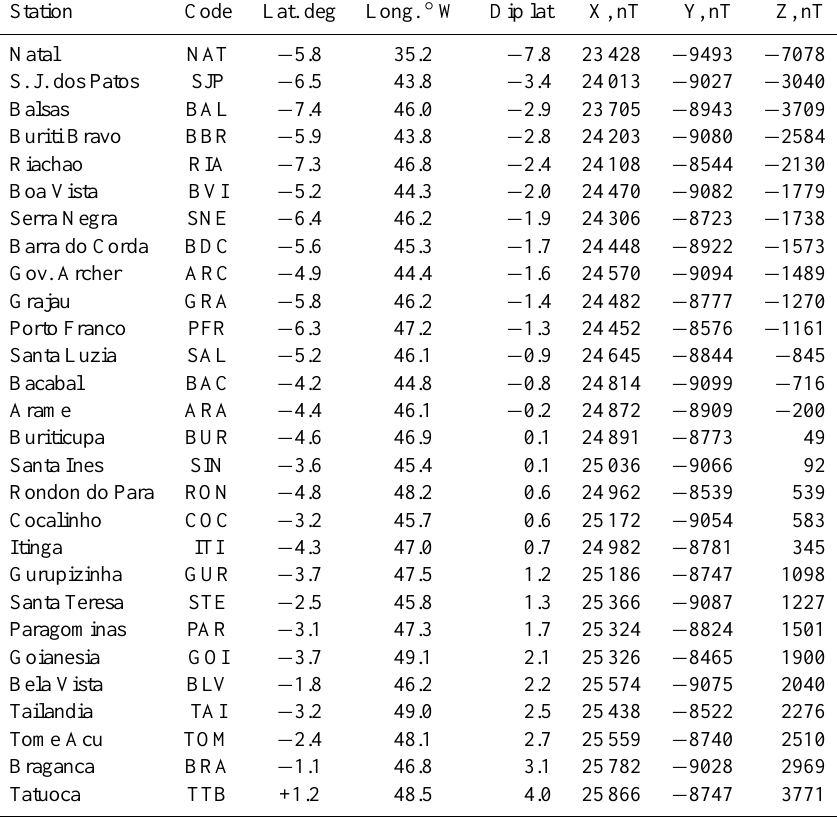
Table 1. Coordinates and magnetic parameters of the stations. Station